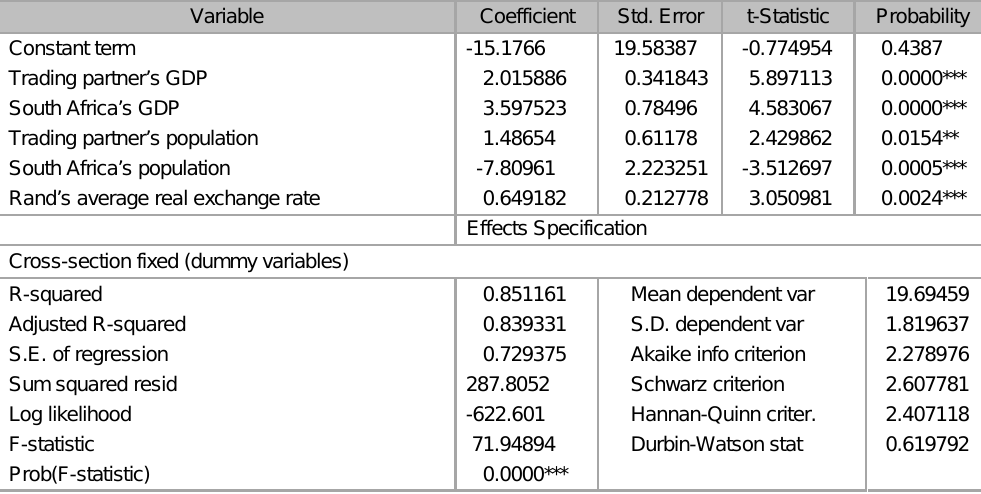
First-stage (fixed effects model) regression results